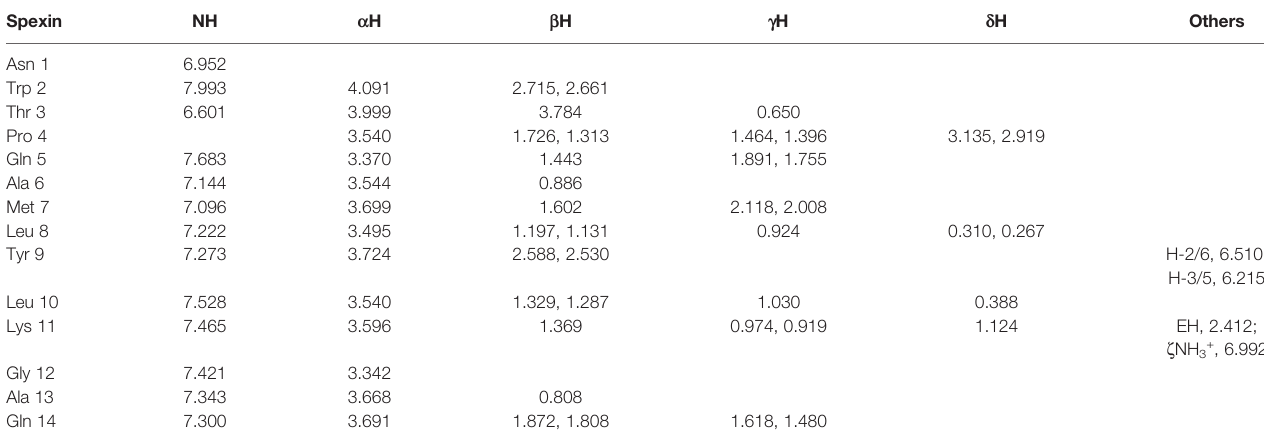
TABLE 1 | 1 H assignment and chemical shift data for mouse SPX (60% TFE at 298 K).